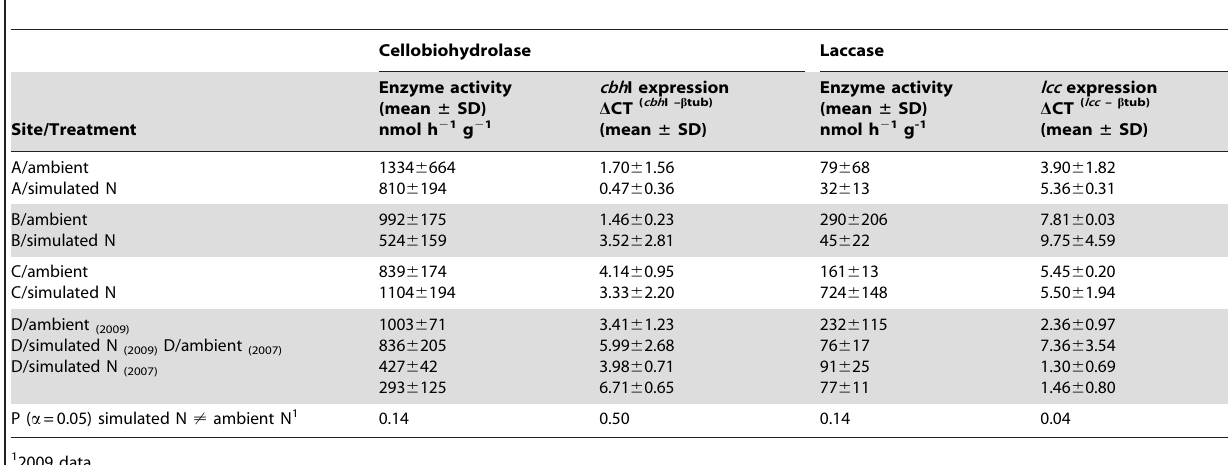
Table 2. Cellobiohydrolase and laccase enzyme activities and gene expression levels under ambient and elevated NO 3 2 deposition in four northern hardwood forests.